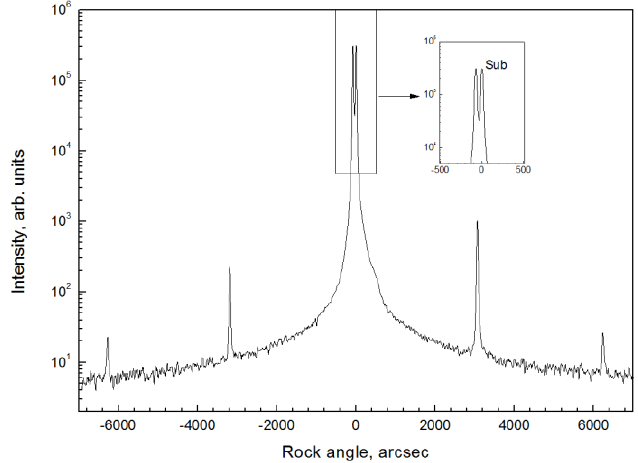
Figure 3. Rocking curve of a superlattice consisting of 250 pairs of Al 0.45 Ga 0.55 As (2.3 nm) / GaAs (3.7 nm) layers.